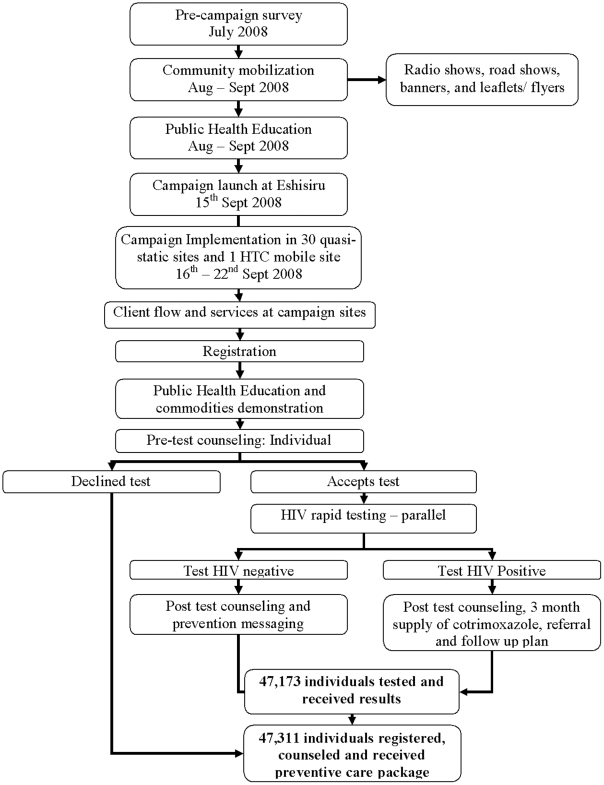
Campaign flow chart.